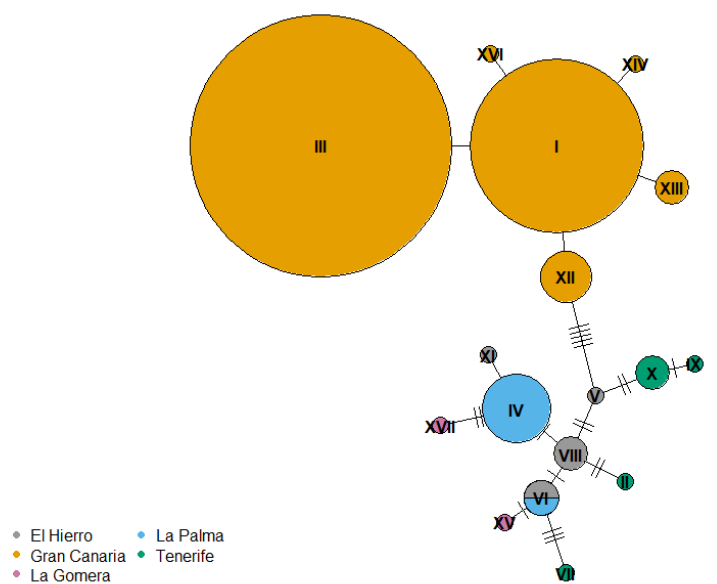
Figure 2. Minimum spanning network of 22 COI haplotypes from 49 individual Canary Islands chiffchaffs sampled in this study, with color indicating the island where the individual was captured. The sizes of the circles are proportional to the haplotype frequencies (smallest circle = 1 individual). Numbers of mutational steps are indicated along the lines connecting